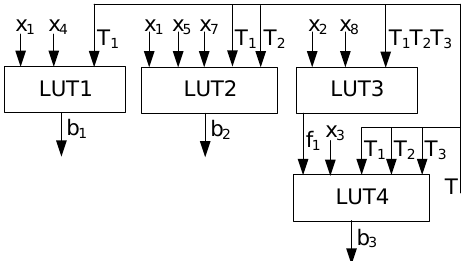
Figure 8. Circuit of block LB for Mealy FSM MP T